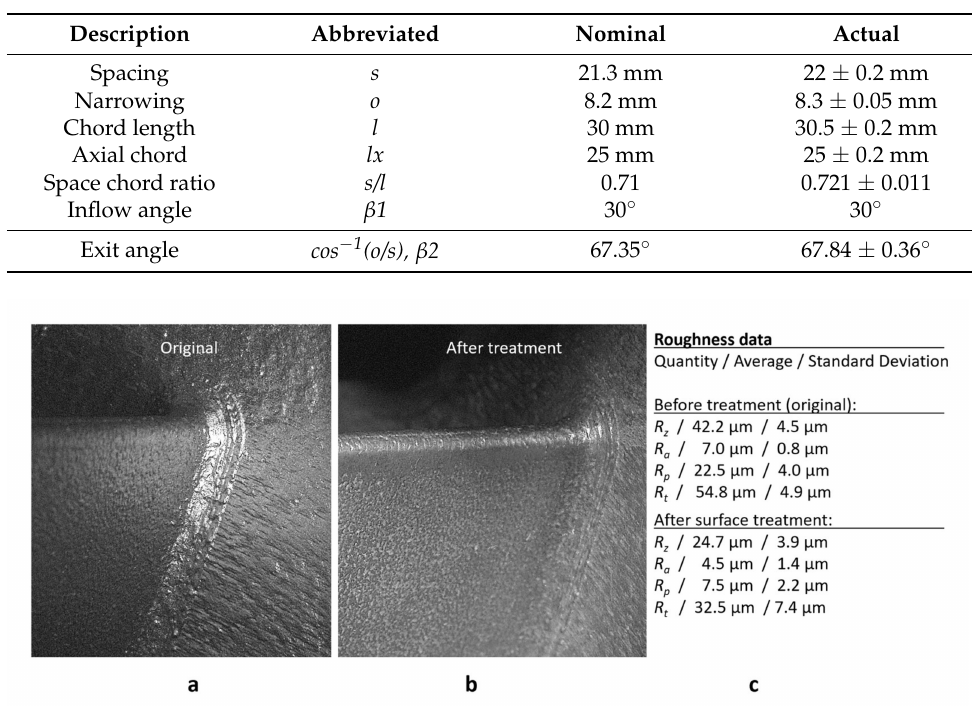
Figure 2. Position: trailing edge, original state ( a ); treatment state ( b ); and measured roughness data ( c ).